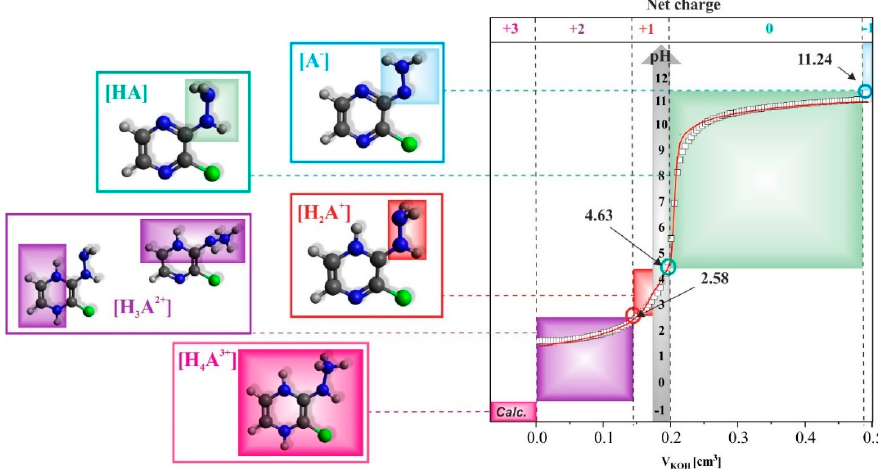
Figure 7. The ionization states as net charge established for the 2Cl3HP based on the potentiometric, spectroscopic as well as calculated data received (left); potentiometric titration data (squares) ob ‐ tained during KOH (10 mM) volume additions to 0.25 mM 2Cl3HP probe dissolved in 1 mM HCl/0.01 M NaClO 4 together with the red line as a result of CVEQUID calculations (right).